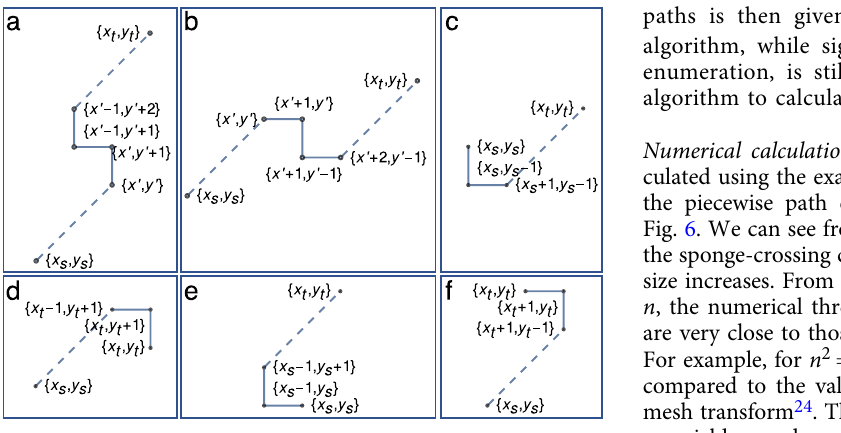
Fig. 5 Characterization of second-shortest paths using primitive steps. Every 2nd shortest self-avoiding path must contain one and only one of the con fi gurations (solid line): either “ Z ” -shape ( a , b ) or “ L ” -shape ( c – f ), then the rest connected by shortest paths (dashed